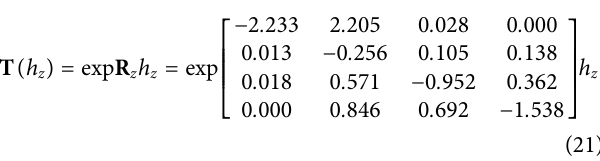
Frontiers in Earth Science |